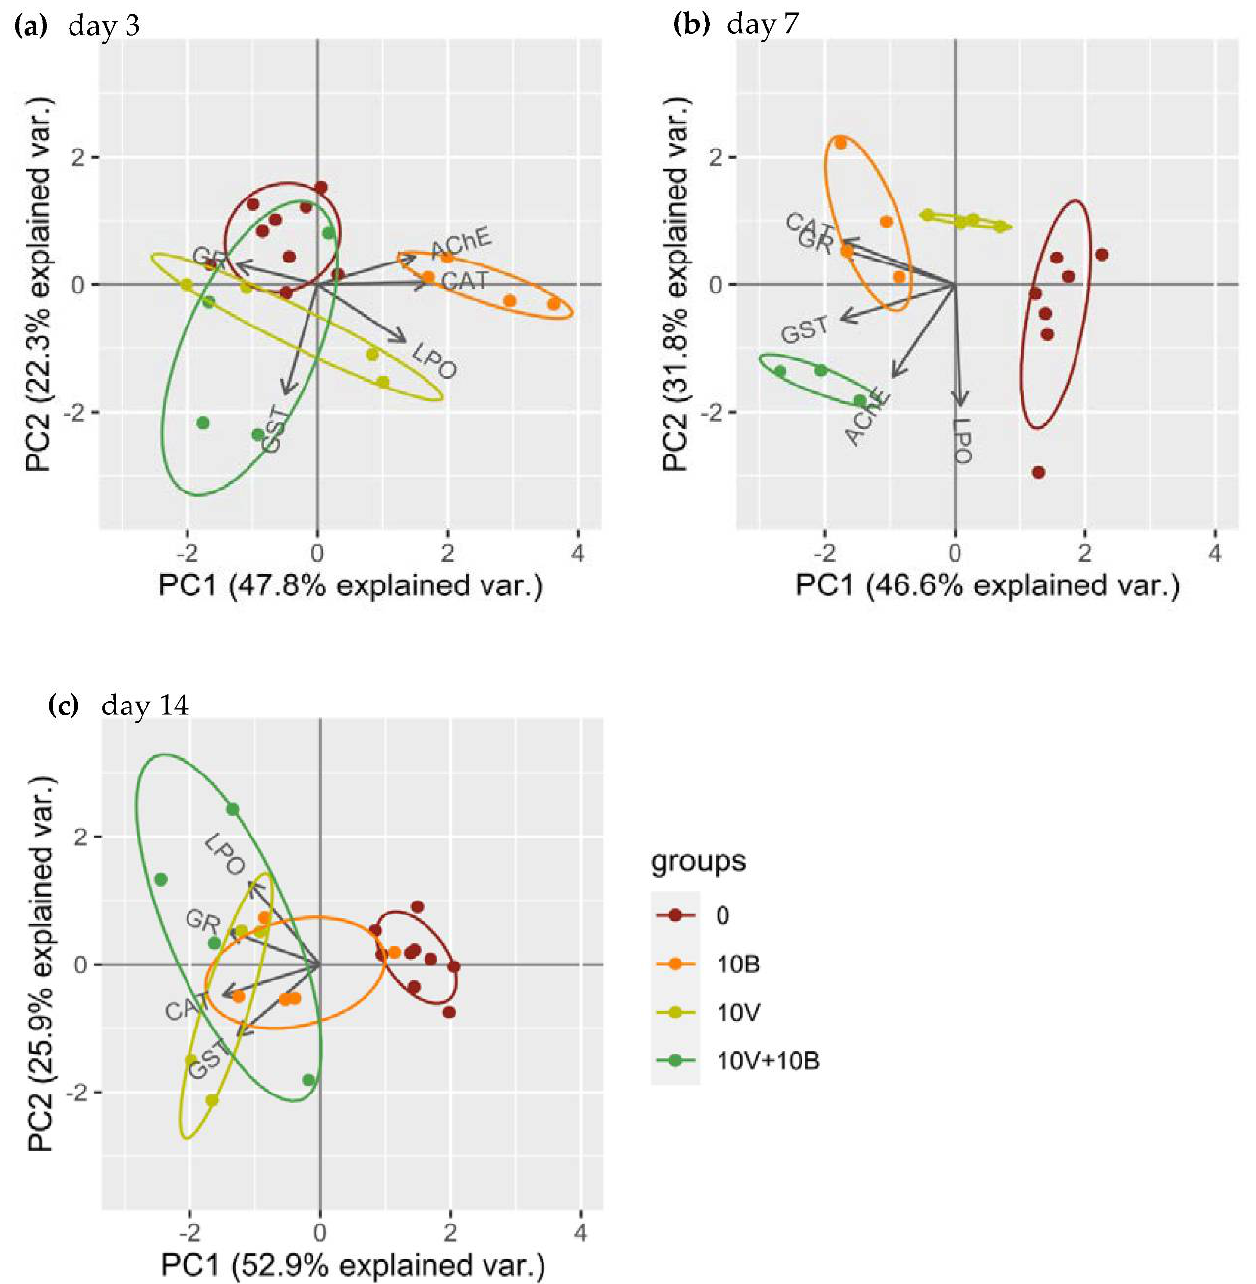
Figure 3. Principal component analysis (PCA) of the biochemical endpoints: catalase (CAT), glutathione reductase (GR), glutathione-s-transferase (GST) and acetylcholinesterase (AChE) activities; and lipid peroxidation (LPO) levels related with the different tested exposures at days: ( a ) 3; ( b ) 7; and ( c ) 14. 0—control and solvent control; 10B—10 mg BNPs/kg soil; 10V—10 mg VNPs/kg soil; 10V + 10B—10 mg VNPs + 10 mg BNPs /kg soil.